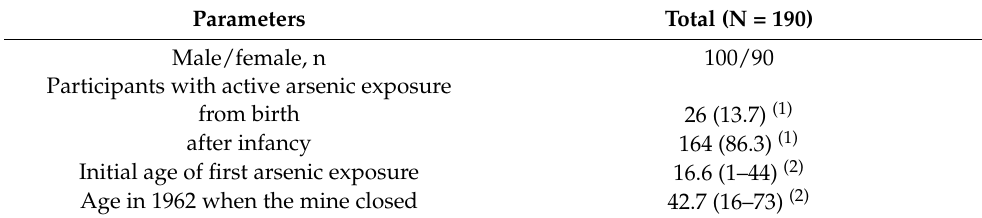
Table 1. Participant characteristics.